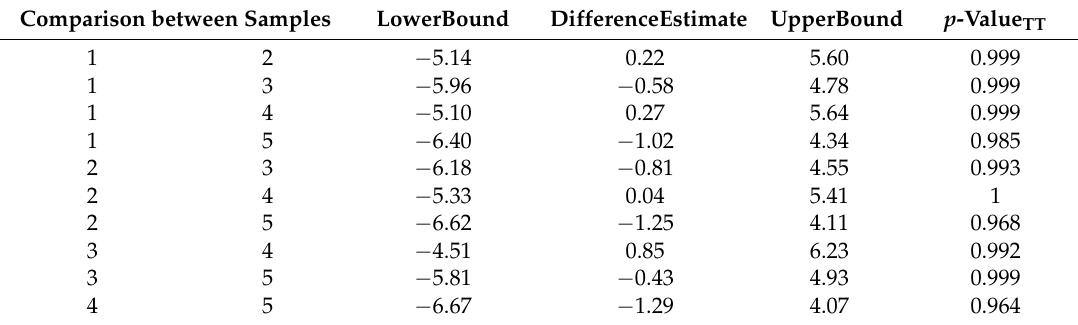
Table 6. One-to-one comparison of the means for the three-months analysis (January–June).